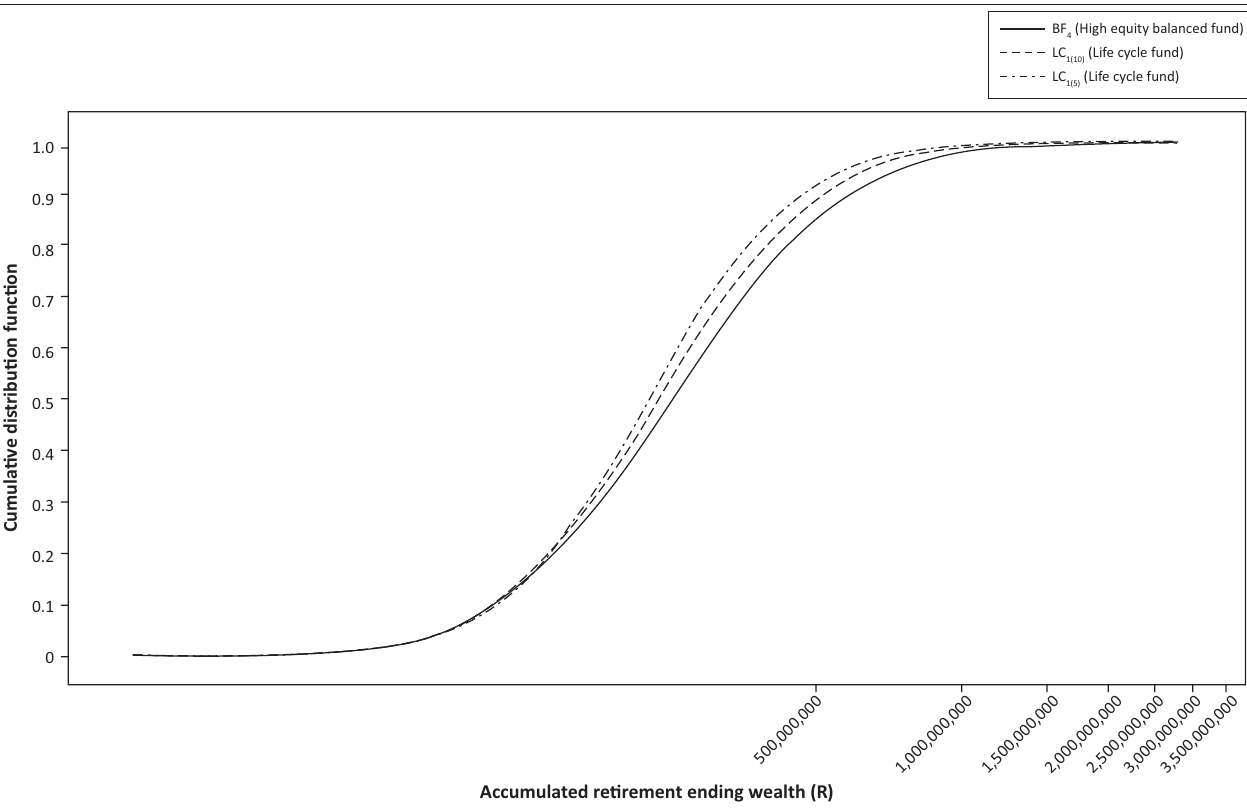
and LC against Model BF 2(10) 2(5) 4